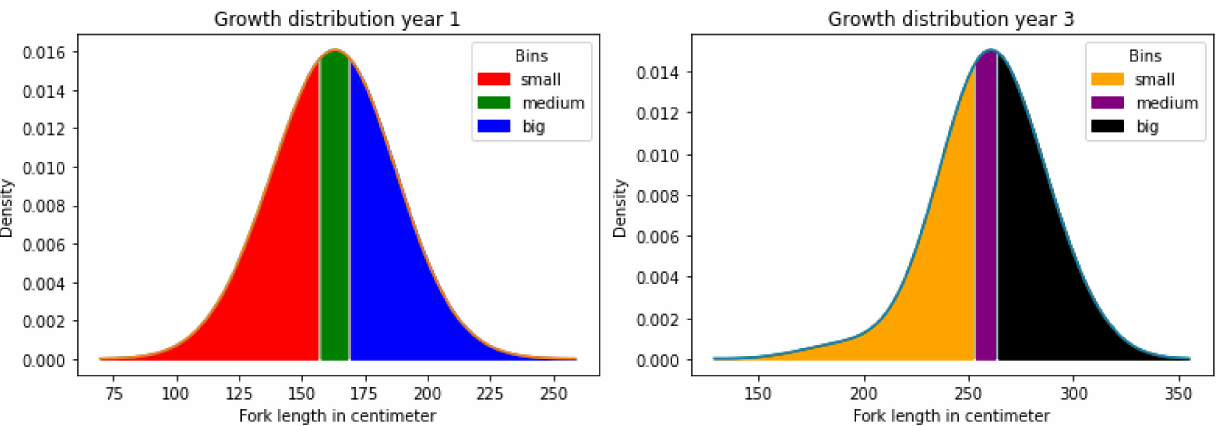
Figure 2. Density plot of the distribution of growth of 1- and 3-year-old snappers. The bins small, medium, and large are coloured red, green, and blue for year 1, respectively, and for year 3 they are orange, purple, and black, respectively.